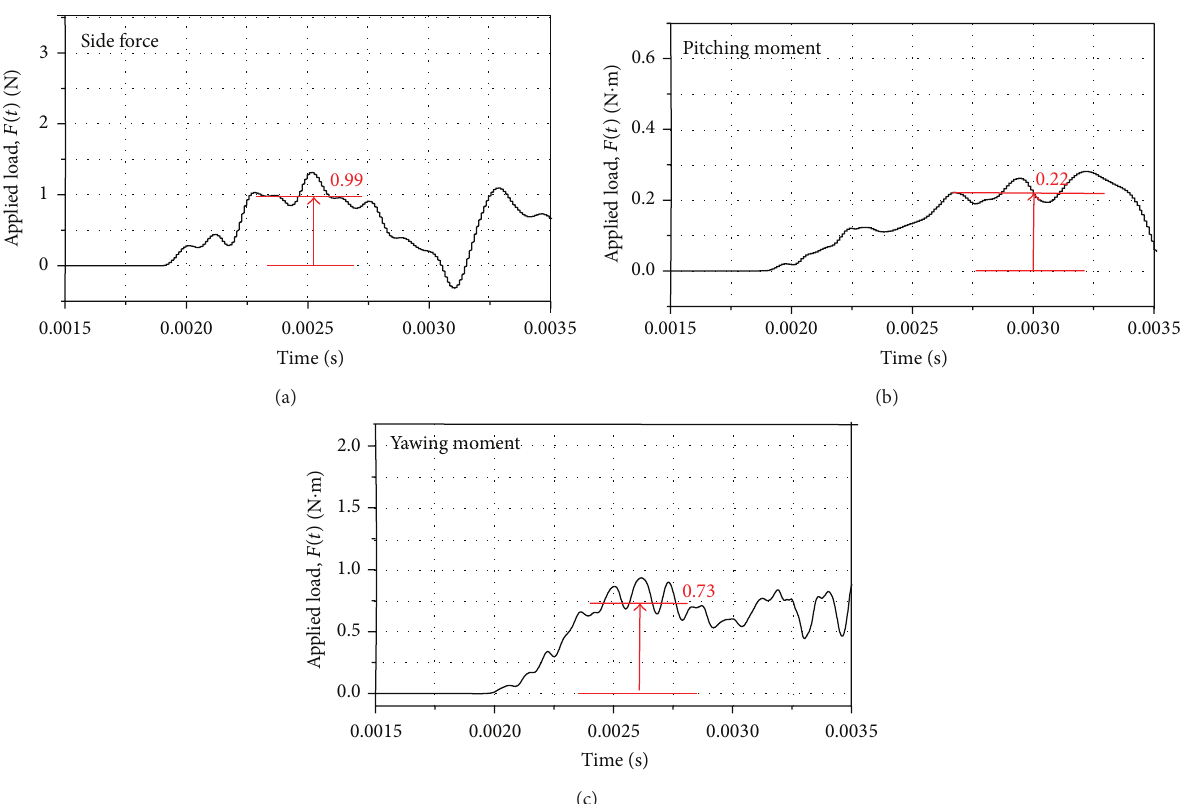
Figure 8: Deconvoluted aerodynamic loads against the system output in Figure